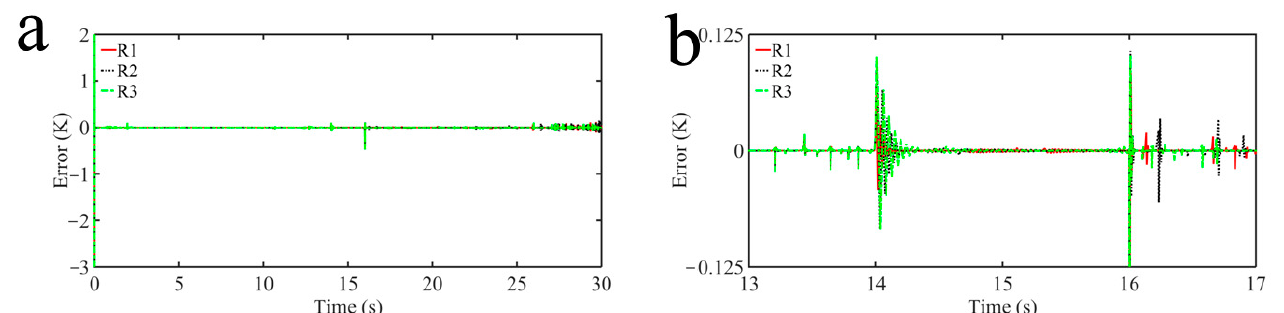
Figure 32. Simulation results with some external disturbances: ( a ) the tracking errors of Wall 2_85 mm for composite controller; ( b ) their partial enlarged figures in details.